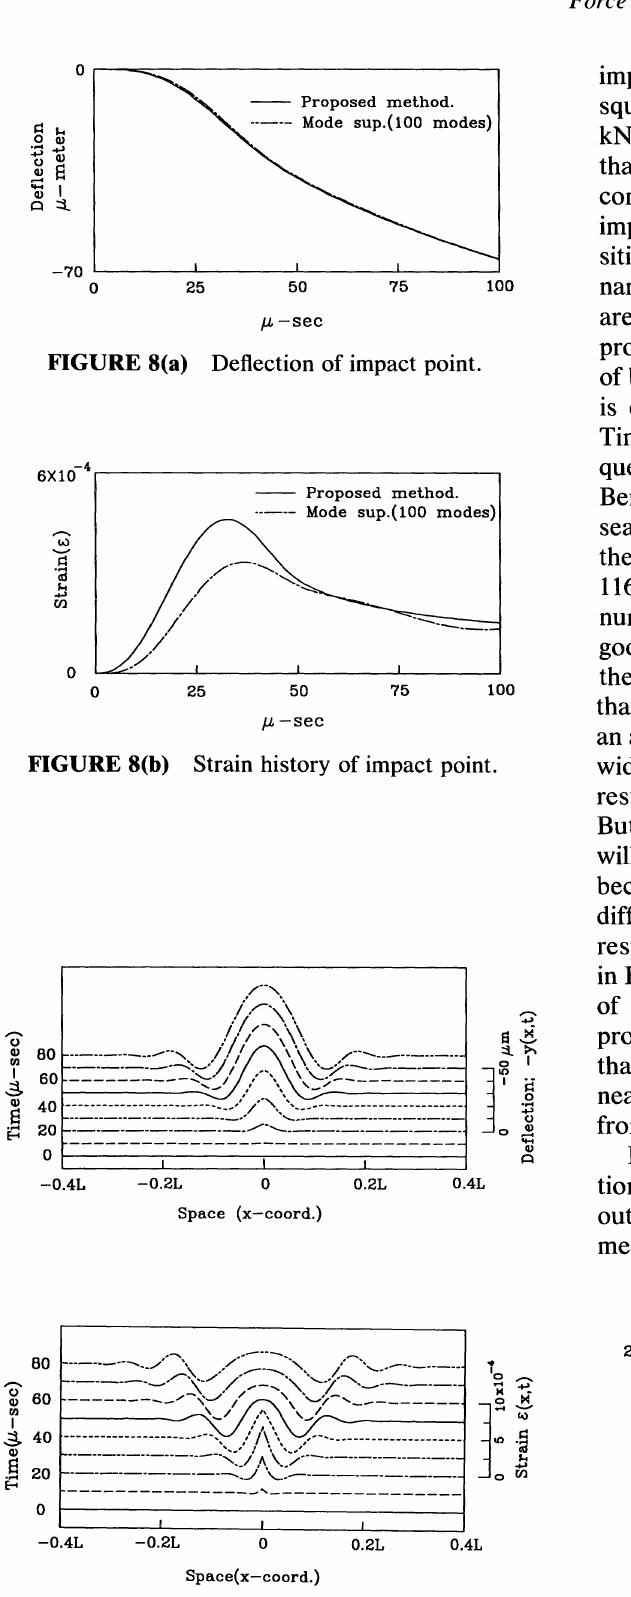
FIGURE 9 Beam response for the simulation input in the time and space domain: (a) deflection shape; (b) strain shape.